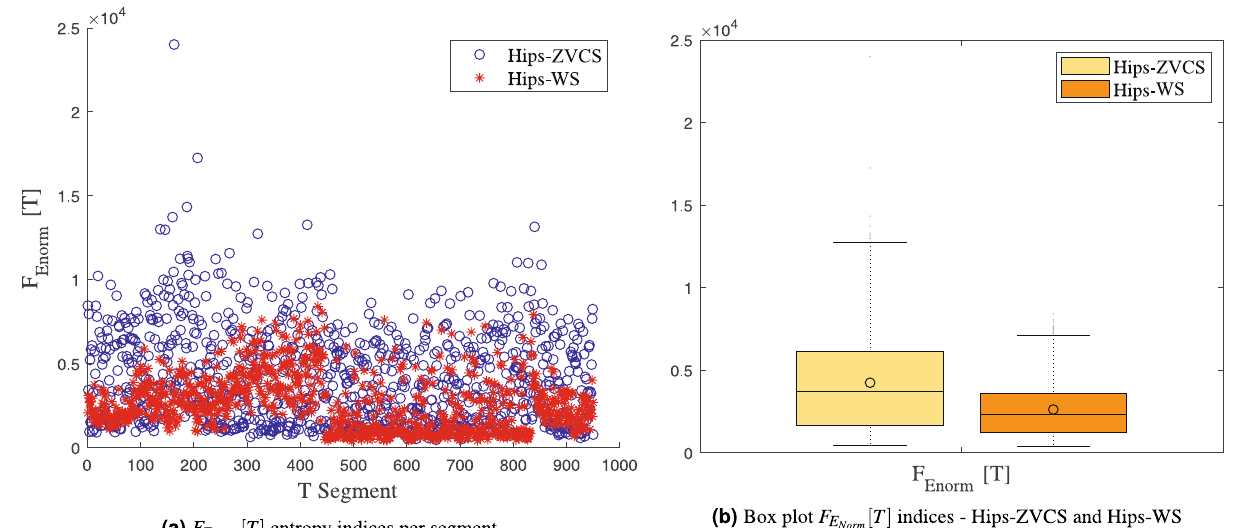
[ T ] entropy measurement Norm